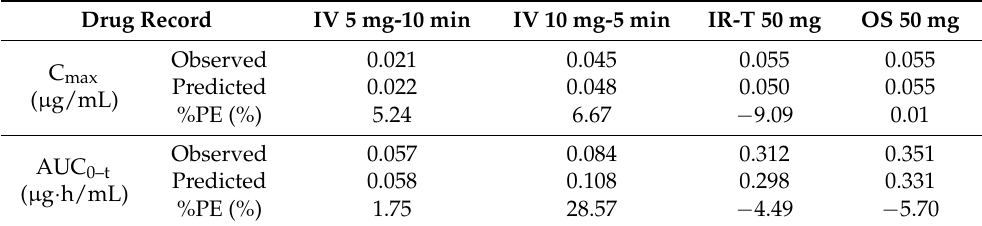
Figure 8. Observed (squares) and simulated (lines) plasma curves of metoprolol while considering the fasted-state 5 mg IV infusion ( a ), 10 mg IV infusion ( b ), 50 mg IR tablet ( c ), 50 mg IR oral solution ( d ), 25 mg CR tablet-A ( e ), and 200 mg CR tablet-C ( f ); and fed-state-200 mg CR tablet-D ( g ) and 200 mg CR tablet-E ( h )-from different formulations. Table 11. In vivo and in silico data of IV and IR oral formulations used to develop and validate the model, as well as their respective %PE